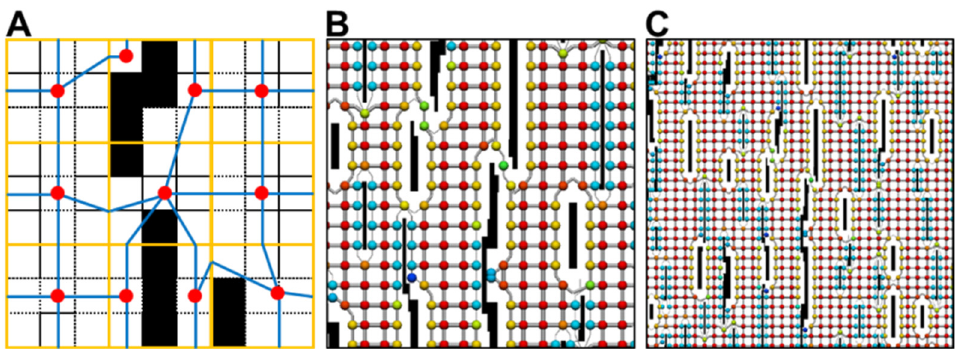
Figure A2. Discretizations of laminar cleft domain. Domain defined by 300 × 700 pixel binary image. ( A ) Domain is split into blocks of 3 × 3 pixels (orange). Each block is abstracted to a center-of-mass node (red) and edge links (blue). These are linked to form a network. Each pixel size is 0.01 × 0.01 mm. ( B ) The discrete network on a larger scale showing how the network forms around the laminar breaks. Red spheres show the maximum area (0.03 2 mm 2 ) associated with a node, and blue spheres show the smallest area. ( C ) A network view from further back.